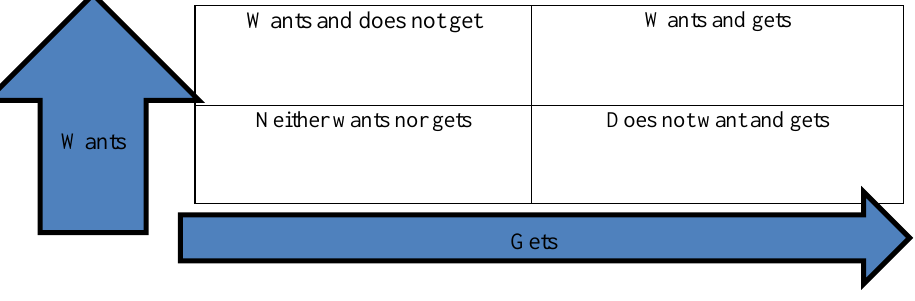
Fig. 2. Analysis of customer satisfaction (Soliddata,